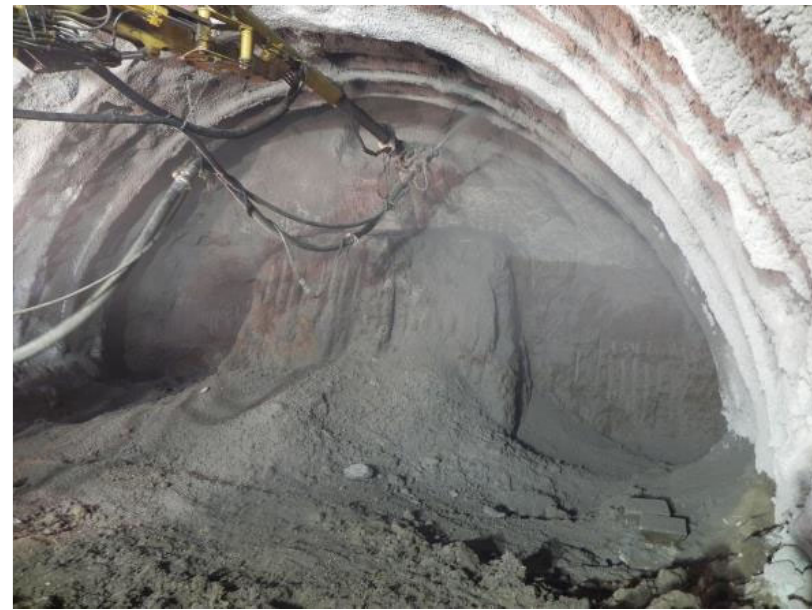
Figure 39. Stabilization of the excavation face south portal.